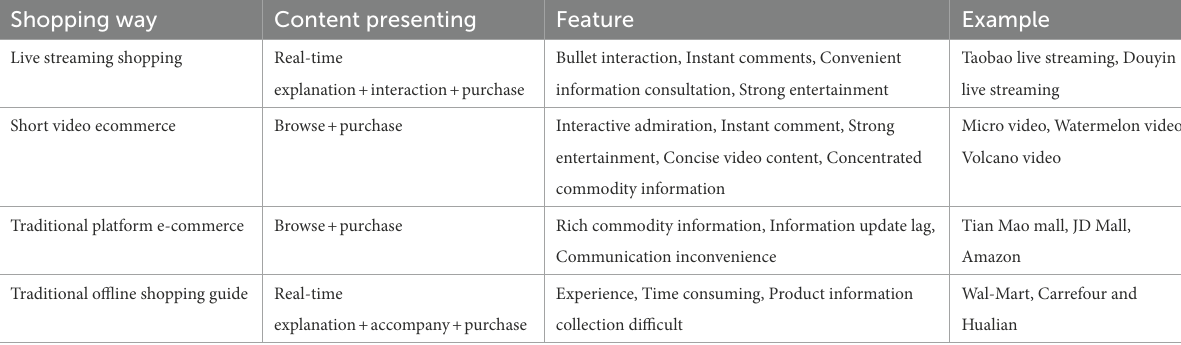
TABLE 1 Comparison between live streaming shopping and other shopping